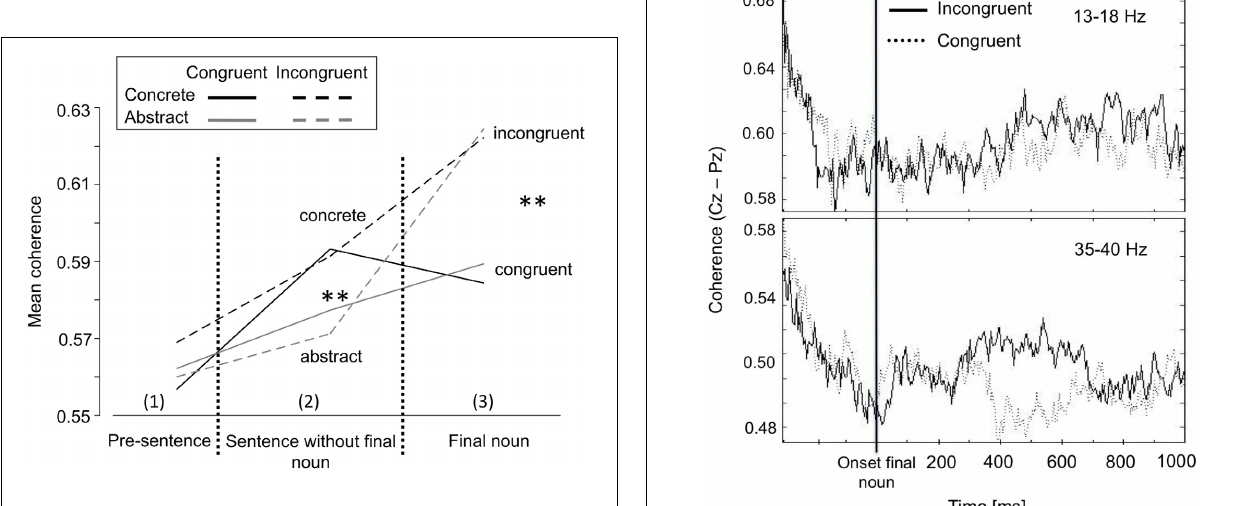
FIGURE 5 | Effect of the sentences’ concreteness and congruence on the mean long-range coherence in the theta frequency band (3–7Hz) at posterior electrodes. Whilst processing the first sentence part there is a significant concreteness effect (both black lines vs. both gray lines), whereas a significant congruence effect is found at the final noun (both broken lines vs. both solid lines). Note that one and the same frequency band shows both effects in different sentence intervals. ∗∗ p < 0 . 01.